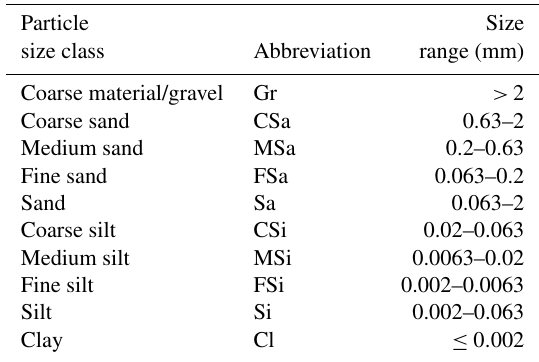
Table A4. Size ranges of particle size classes (DIN